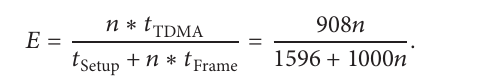
can be calculated Setup